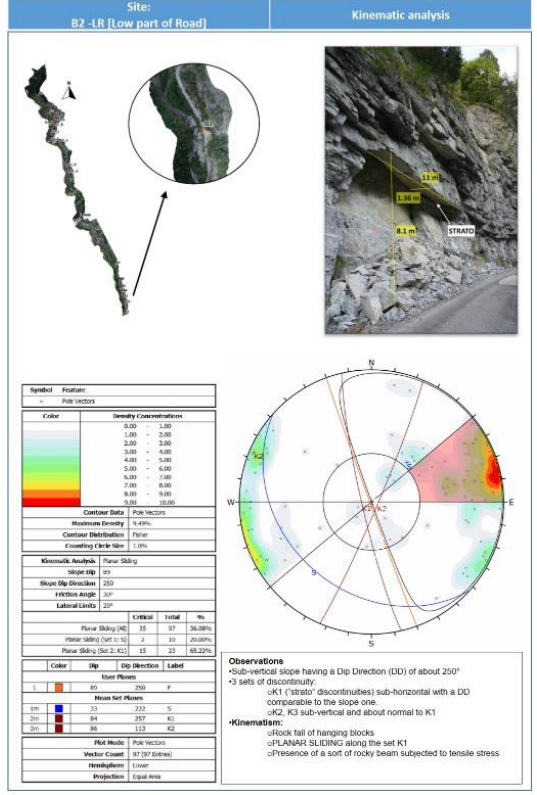
Figure 12. Example of stereographic projection of the collected plane for discontinuities sets